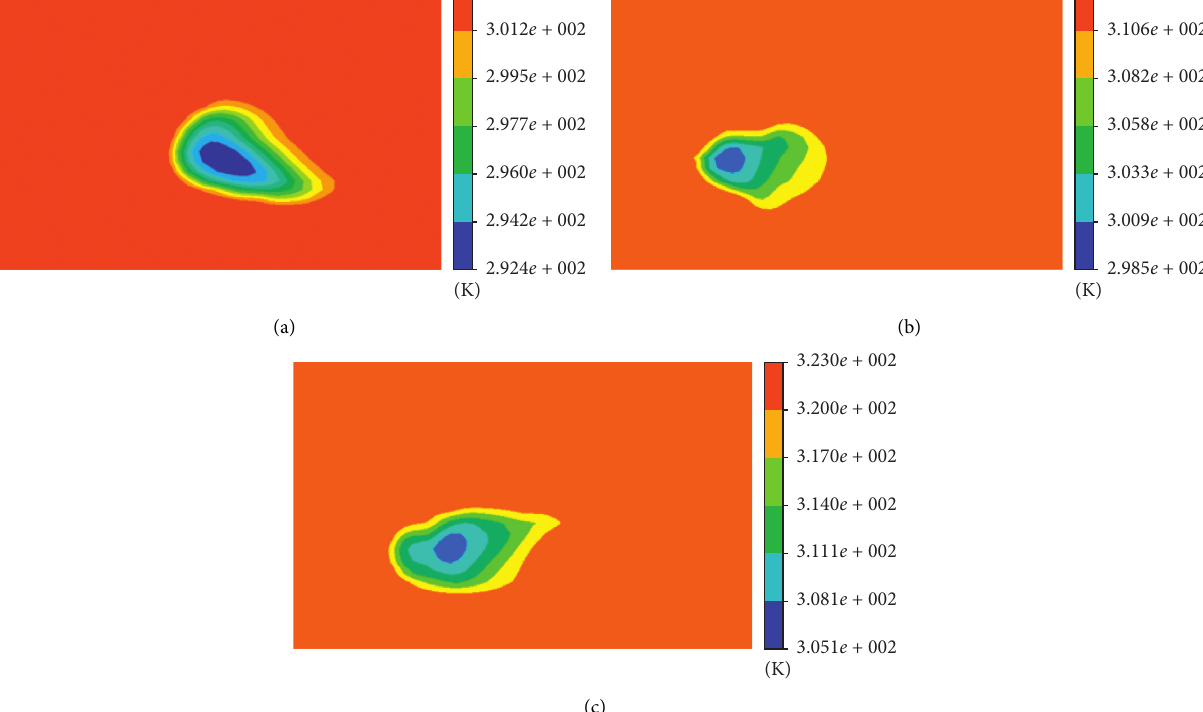
Figure 5: Bubble internal temperatures under different preheating temperatures at the laying pressure of 0.5MPa and the laying speed of 40mm/s. (a) The preheating temperature of 303K. (b) The preheating temperature of 313K. (c) The preheating temperature of 323K.